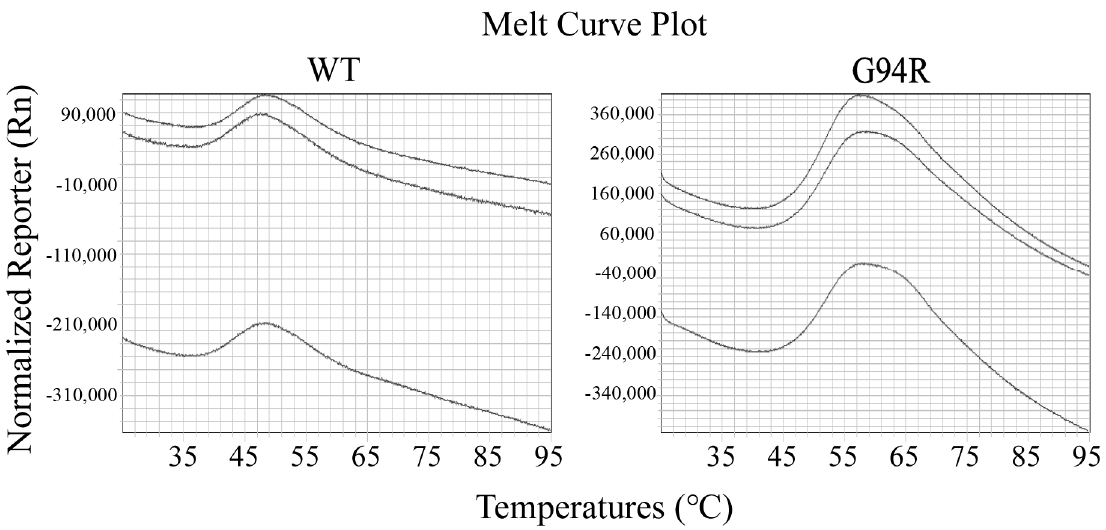
Figure 7. Thermofluor assay for the dissolution temperatures (Tm) of the wild-type and G94R antibodies. Thermal stability of the WT and mutant scFvs were monitored using SYPRO Orange staining and detected using the Quantstudio 7 Flex. As the temperature increases, upon reaching Tm, the protein conformation is destroyed, and the dye can bind to the hydrophobic region. Three repetitive tests were carried out, and only one result was demonstrated